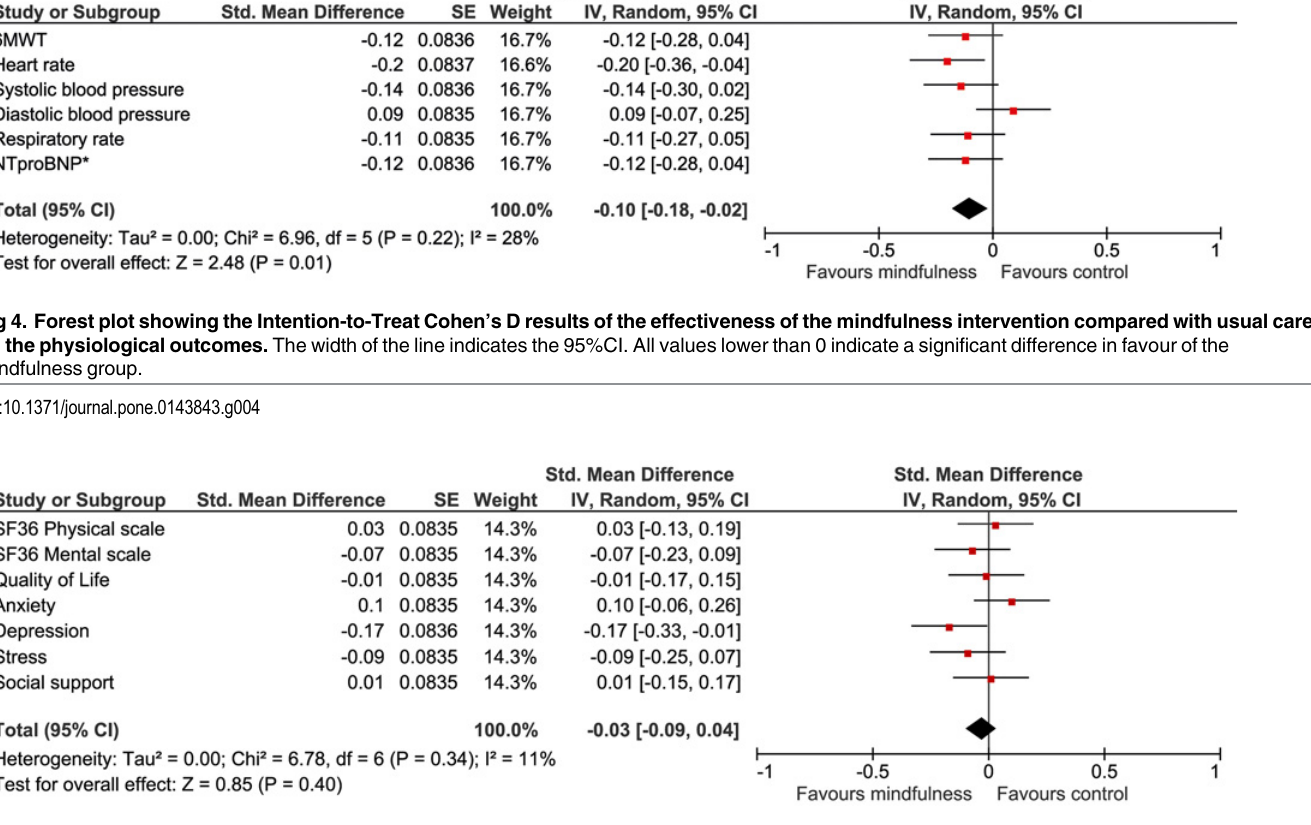
Fig 5. Forest plot showing the Intention-to-Treat Cohen ’ s D results of the effectiveness of the mindfulness intervention compared with usual care on the psychological outcomes. The width of the line indicates the 95%CI. All values lower than 0 indicate a significant difference in favour of the mindfulness group.